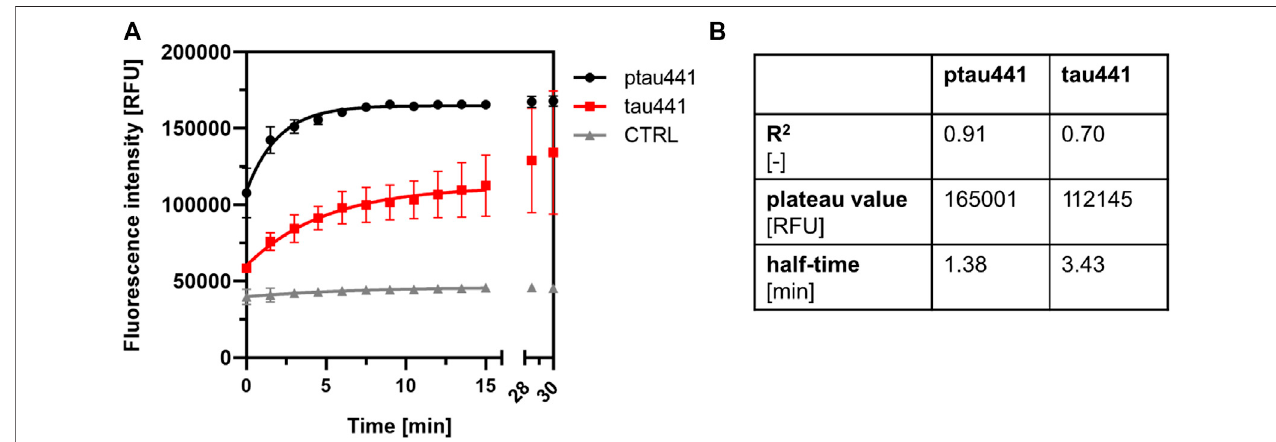
FIGURE 7| CK1 δ -mediated phosphorylation islinked to tau aggregation. (A) Tau aggregation assay was performed with CK1 δ -phosphorylated tau441 (ptau441) and non-phosphorylated tau441 (tau441). Control reaction (CTRL) was performed with standard reaction mix without protein. Tau aggregation was measured by the ThSassayat480 nm.Shownarethemeanvaluesofthetriplicatesandtheerrorbarsofthestandarddeviation.Datawere fi ttoone-phaseassociationexponentialmodel within the fi rst 15 min. (B) Amount of formed aggregates and velocity of aggregation was calculated as plateau value [RFU] and half-time [min]. CTRL: control reaction, ptau441: CK1 δ -phosphorylated tau441, RFU: relative fl uorescence units, tau441: non-phosphorylated tau441.